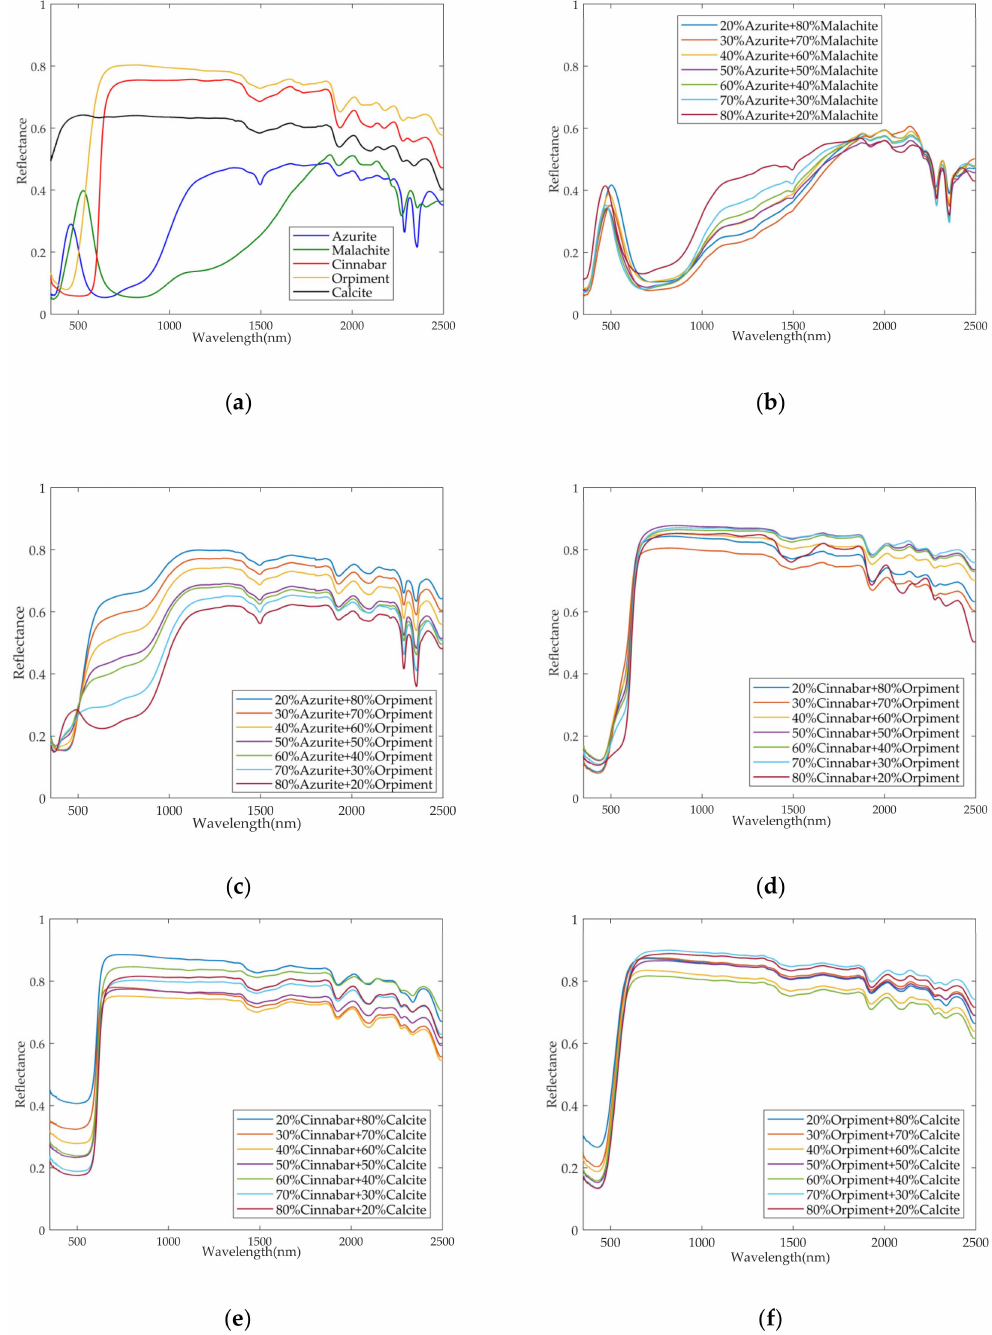
Figure 5. Spectra of pure pigments and mixed pigments in different mass ratios: ( a ) pure pigment spectra; ( b ) azurite and malachite mixed spectra; ( c ) azurite and orpiment mixed spectra; ( d ) cinnabar and orpiment mixed spectra; ( e ) cinnabar and calcite mixed spectra; ( f ) orpiment and calcite mixed